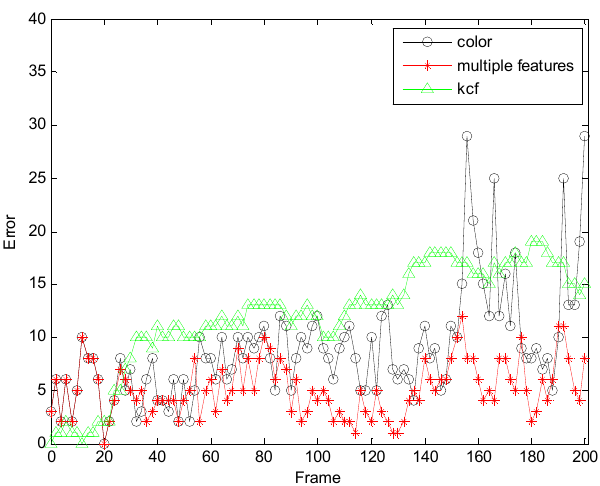
Figure 18. The RMSE comparison corresponding with KCF.